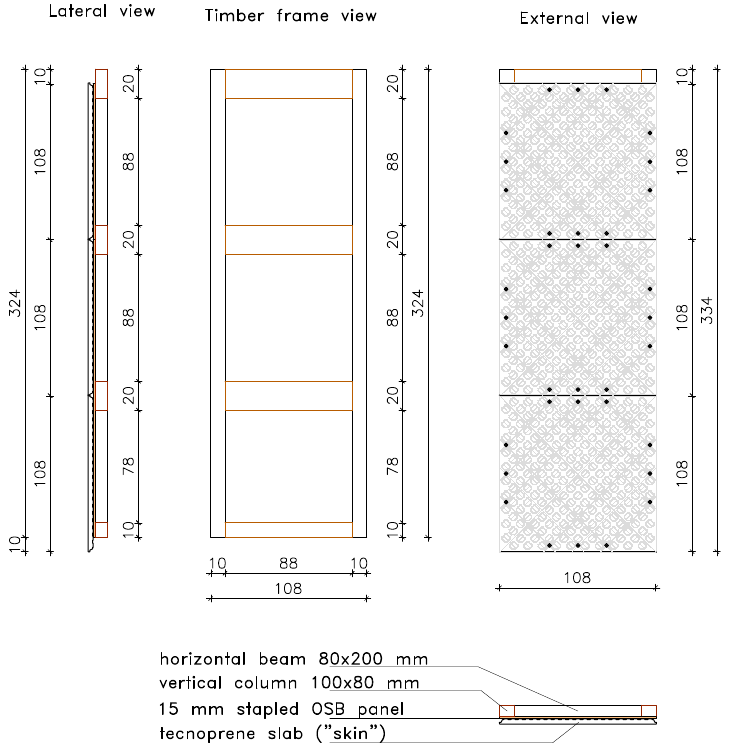
Figure 1. View of the modular shear wall (where not specified dimensions are in cm).